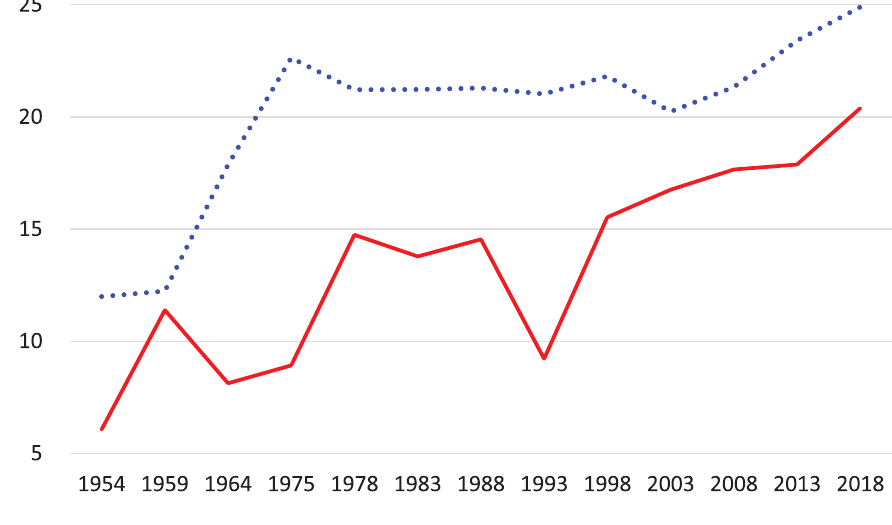
Figure 6. Percentage of female deputy in the NPC and CPPCC: China 1954–2018. Sources: “The proportion of women in CPPCC and NPC has reached a new high” (2018) and NSB (2012, Tables 7–1 and 7–2) for the 2013 and 2018 data. National Congress of the CCCPC in 2018 emphasized that the work of training and selecting female cadres, ethnic minority cadres and non-Party cadres should be well